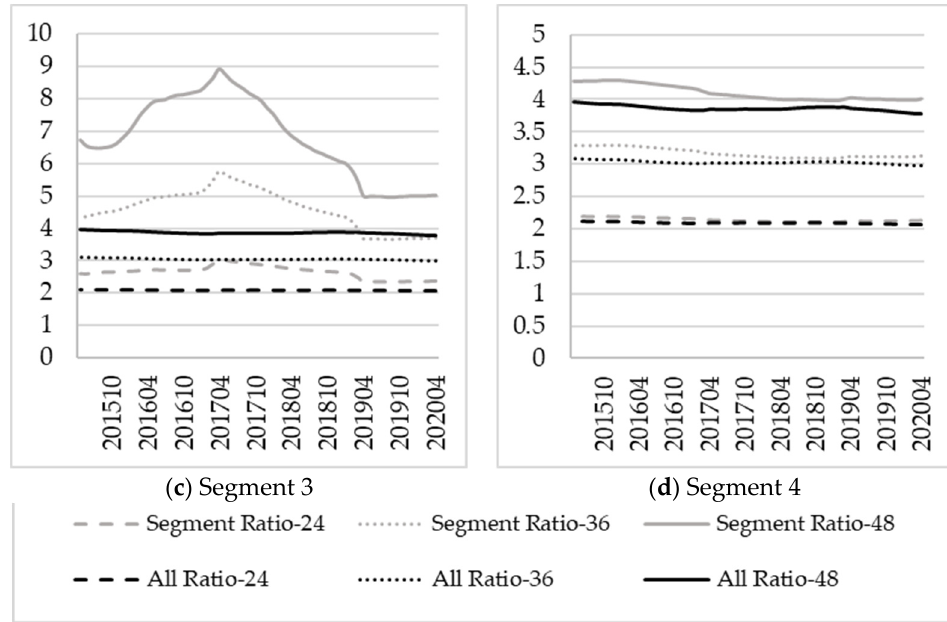
Figure 4. The ratios of cumulative segmented PDs over different horizons.